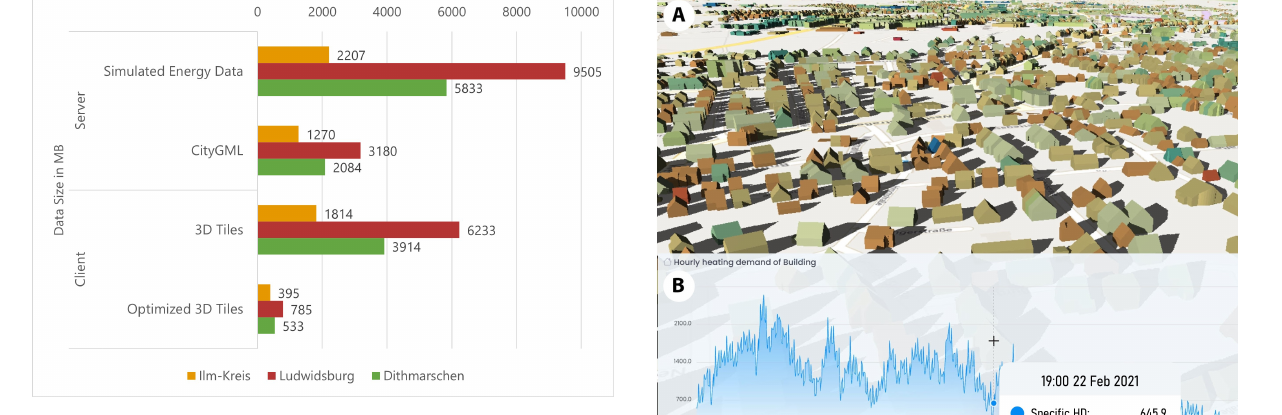
Figure 6. A chart illustrating the data size of the server-side data storage (Simulated Energy Data and CityGML) and the data for client-side rendering (3D Tiles and Optimized 3D Tiles) of the three selected case study regions.